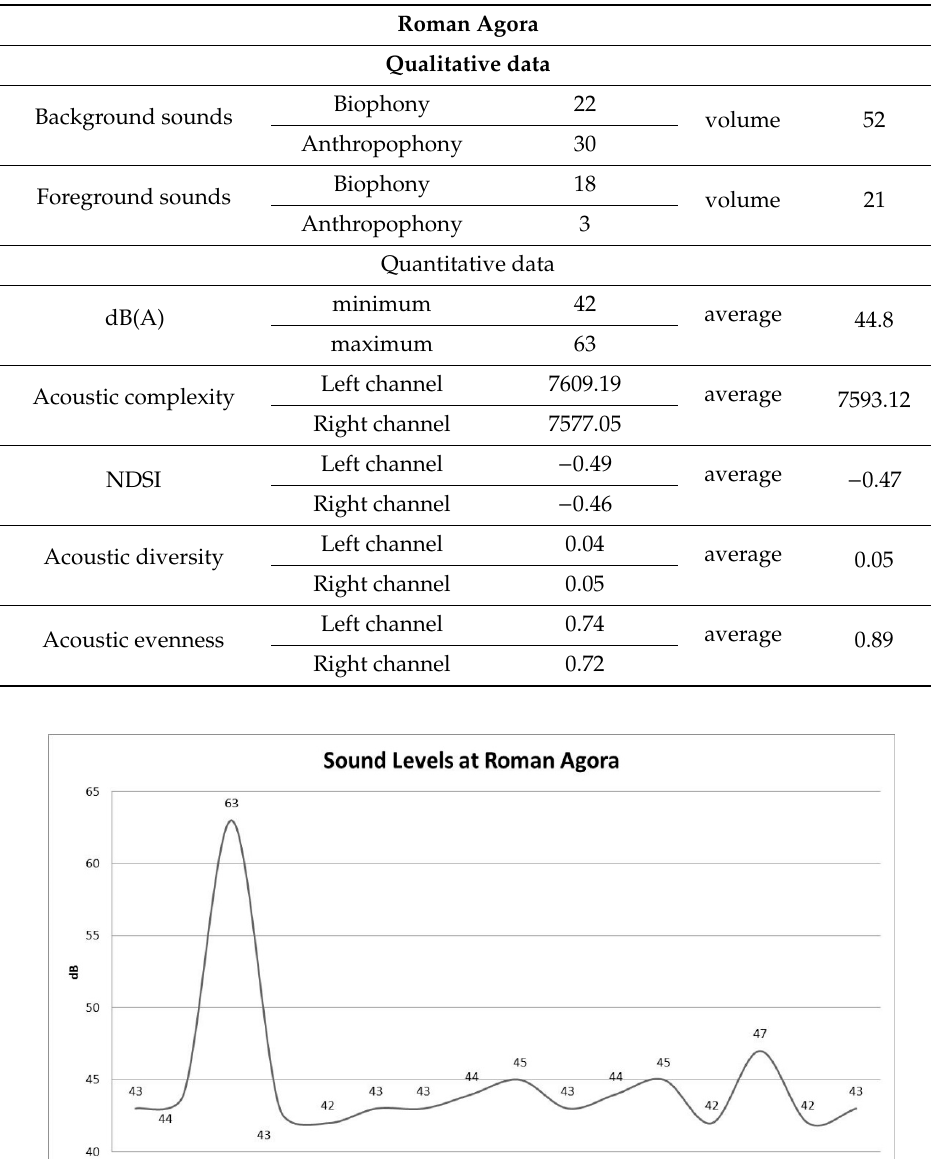
NDSI highlighted the fact that anthropophonic sounds prevailed.